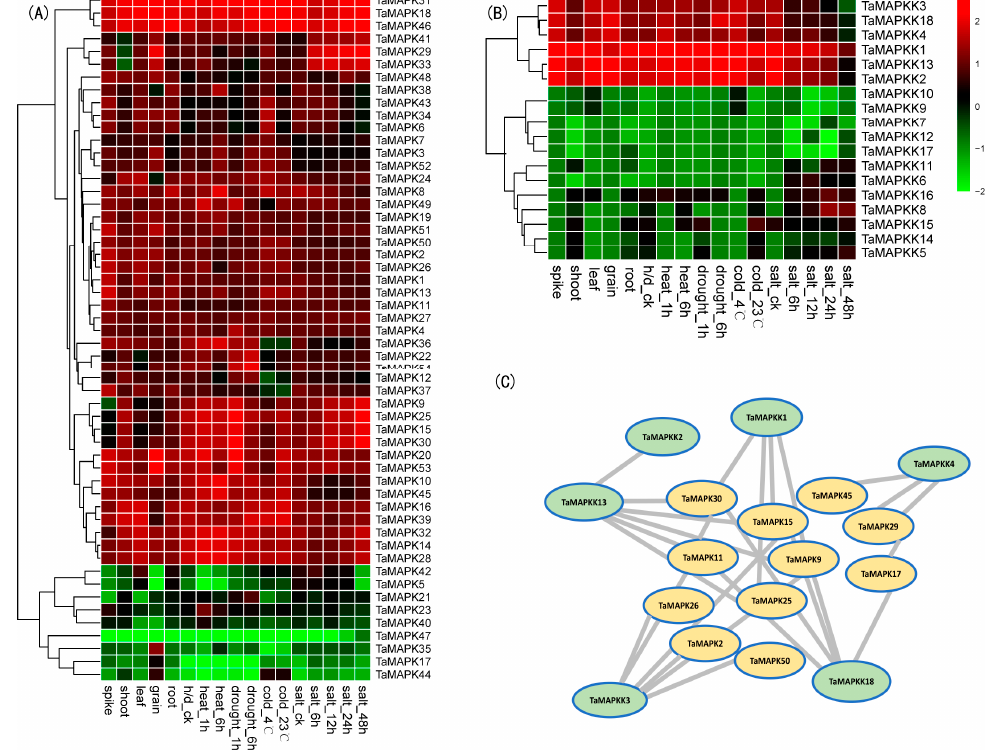
Figure 3. Expression patterns and interaction network of MAPK/MAPKK genes in wheat. ( A ) Relative expression levels of MAPK genes in various tissues and under different abiotic stresses determined using RNA ‐ seq. Red represents increased and green represents decreased expression level; ( B ) Relative expression level of wheat MAPKK genes in various tissues and under abiotic stresses determined using RNA ‐ seq; ( C ) The interaction network of MAPK/MAPKK genes in wheat.